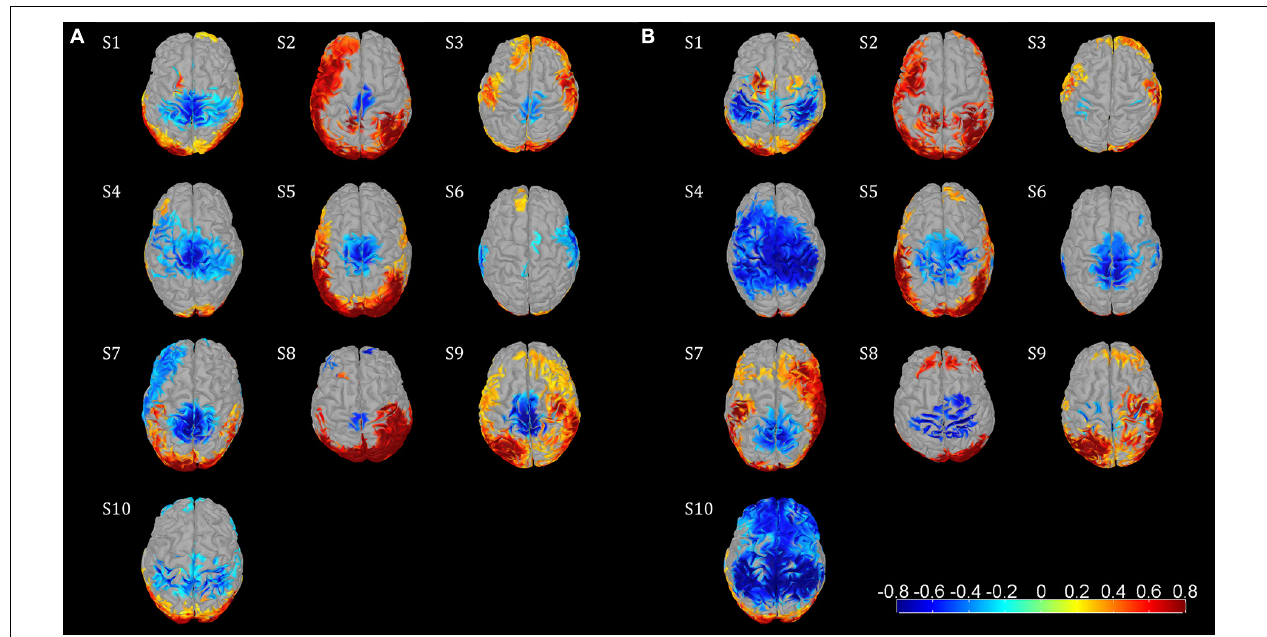
topographies, figure setting as in (A) . Individual center frequencies were used for the μ and β rhythm in every subject which showed most ERD, whereas all μ peaks were identified at 10–12 Hz and all β peaks were between 18–30 Hz; the specific frequencies are listed in Table 1 . Based on these functional topographies the central sensorimotor ROI was identified individually for every